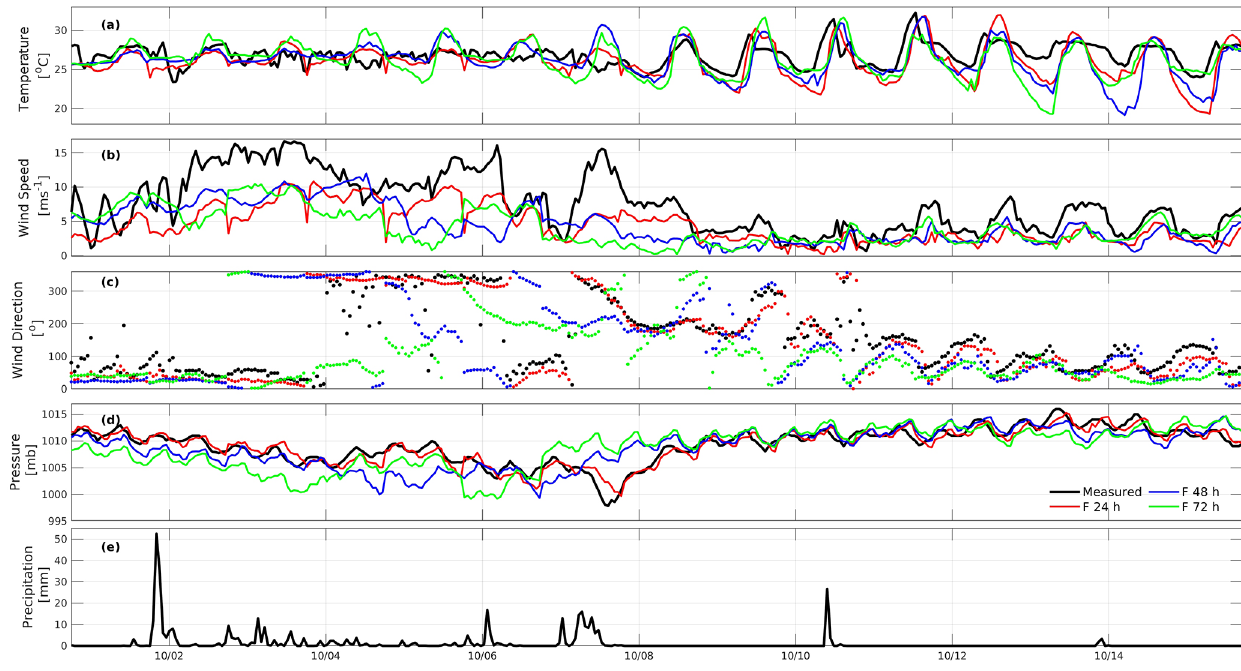
Figure 11. Measured (black line) and forecast modeled time series of (a) air temperature, (b) wind speed, (c) wind direction, (d) atmospheric pressure, and (e) precipitation. The red line indicates the 24h forecast, the blue line the 48h forecast, and the green line the 72h forecast of WRF in Sisal, Yucatán, from 1 to 15 October 2020. The date format is mm/dd.